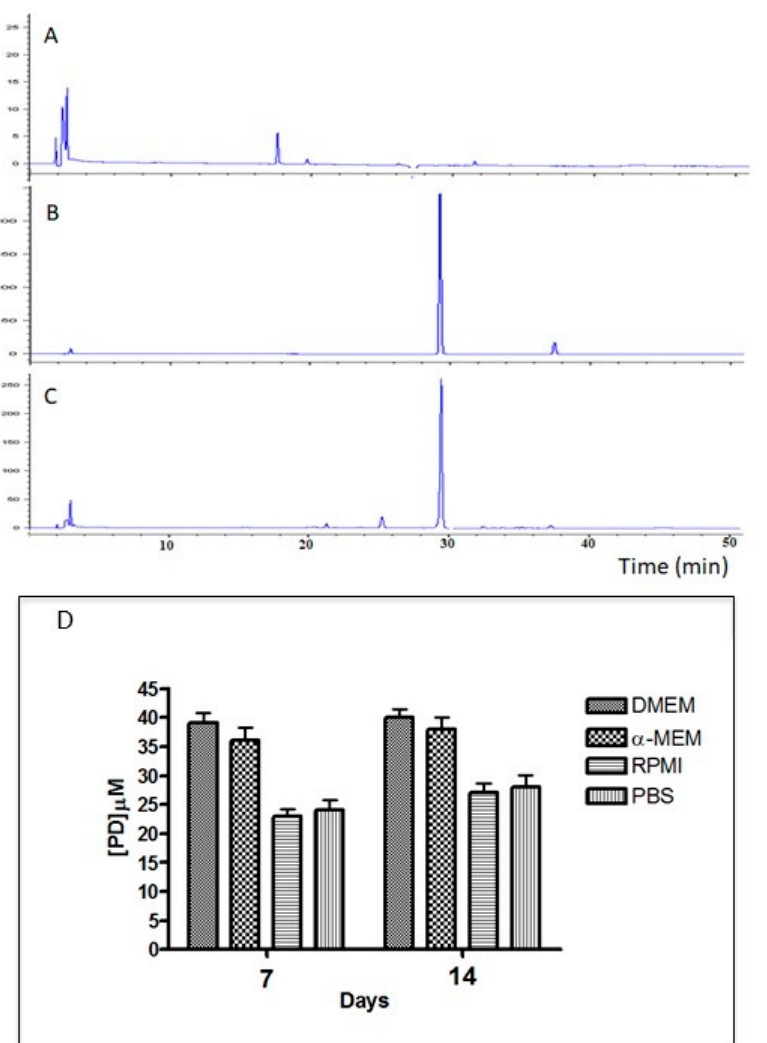
Figure 2. Analysis of the release of PD from PD-PCL nanofibers. ( A ) RT-HPLC spectrum of media (DMEM), ( B ) RT-HPLC spectrum of PD standard (14 ng/ µ L), and ( C ) RT-HPLC spectrum of PD released in DMEM from the PD-PCL scaffold. The release of PD was sustained for up to 14 days in PD-PCL without a burst effect. ( D ) PD released from PD-PCL after 7 and 14 days of incubation under different experimental conditions as evaluated by RT-HPLC.